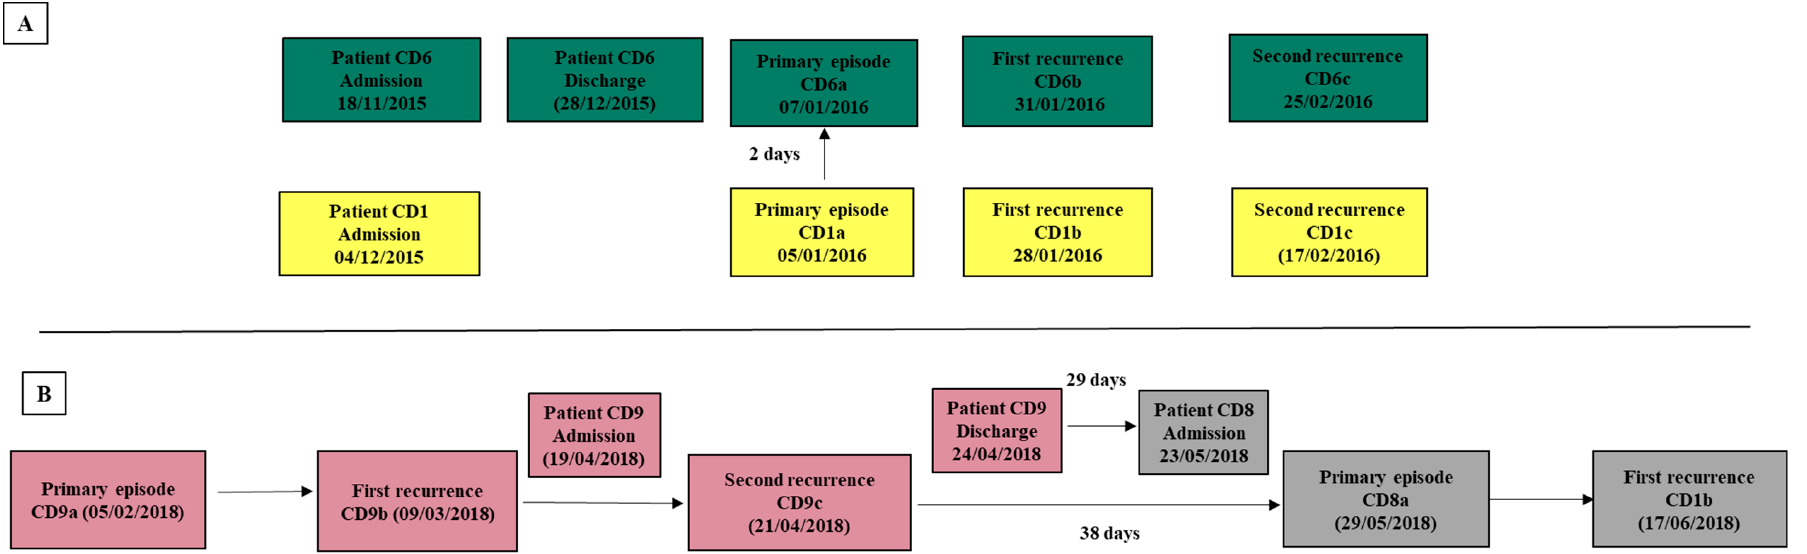
Figure 2. Representation of the two plausible transmission events within patients (each color represents different patients) ( A ) CD1 and CD6, admitted during a common period; and ( B ) patients CD8 and CD9, not admitted to hospital at the same time.